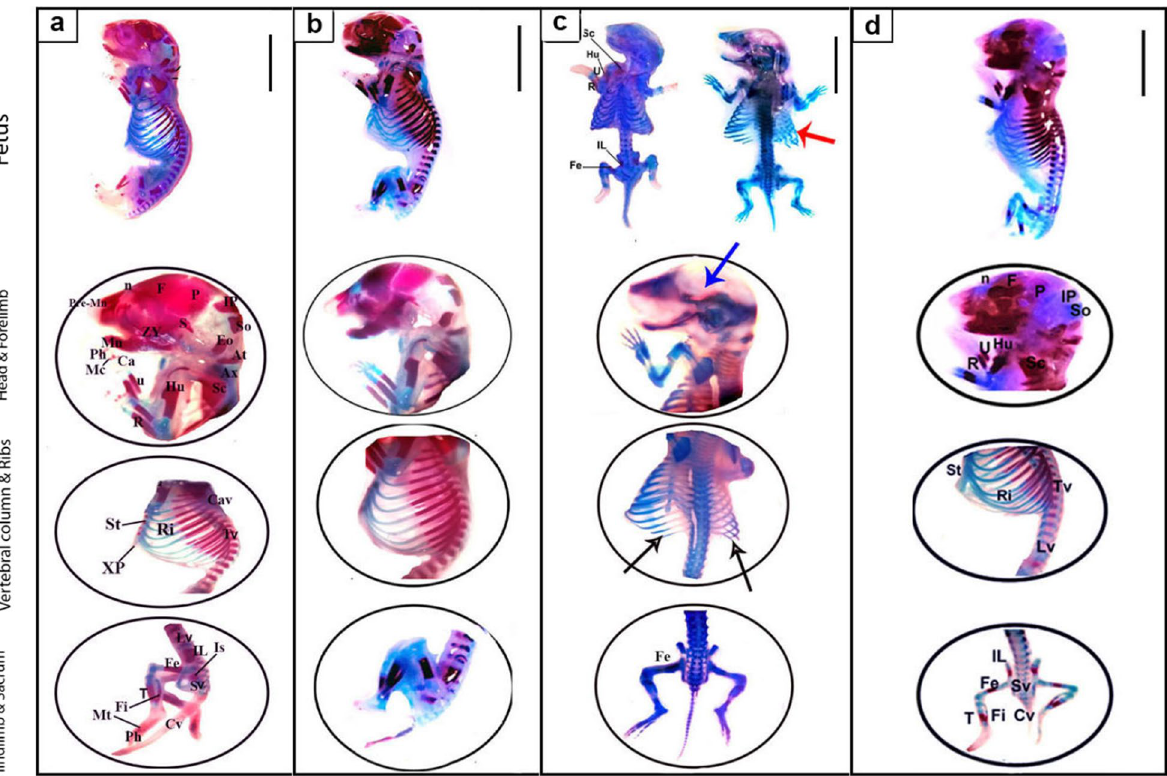
Fig. 1 Photographs of the double‑stained endoskeleton of fetuses and their body parts from different groups. a Control group; normal ossification of the cranial, forelimbs and hindlimbs bones, complete ossification of the vertebral column and normal appearance of ribs. b Ginger group; normal ossification of the endoskeleton. c Labetalol group; severe lack of ossification in the whole skeleton, loss of some cranial bones (blue arrow), wavy ribs (red arrow) and costal separation anomaly (black arrows). Also, some fetuses showed pinpoint ossification areas in the hummers, radius and ulna of the right forelimb and in the femur and ileum of the right and left hind limbs. d Labetalol ginger group; overall amelioration in the + ossification of the endoskeleton but some bones of the skull, vertebral column and limbs with incomplete, slight or lacking ossification can be seen. Atlas (At), axis (Ax), carpus (Ca), caudal vertebrae (Cav), cervical vertebrae (Cv), exoccipital (Eo), frontal (F), femur (Fe), fibula (Fi), humerus (Hu), ilium (IL), interparietal (Ip), ischium (Is), lumbar vertebrae (Lv), metacarpus (Mc), mandible (Mn), metatarsus (Mt), nasal (n), parietal (P), phalanges (Ph), pre‑maxilla (Pre‑M), radius (R), ribs (Ri), squamosal (S), scapula (Sc), supraoccipital (So), sternebrae (St), sacral vertebrae (Sv), tibia (T), thoracic vertebrae (Tv), ulna (U), xiphoid process (XP), zygomatic (Zy) (Alizarin red S and Alcian blue)